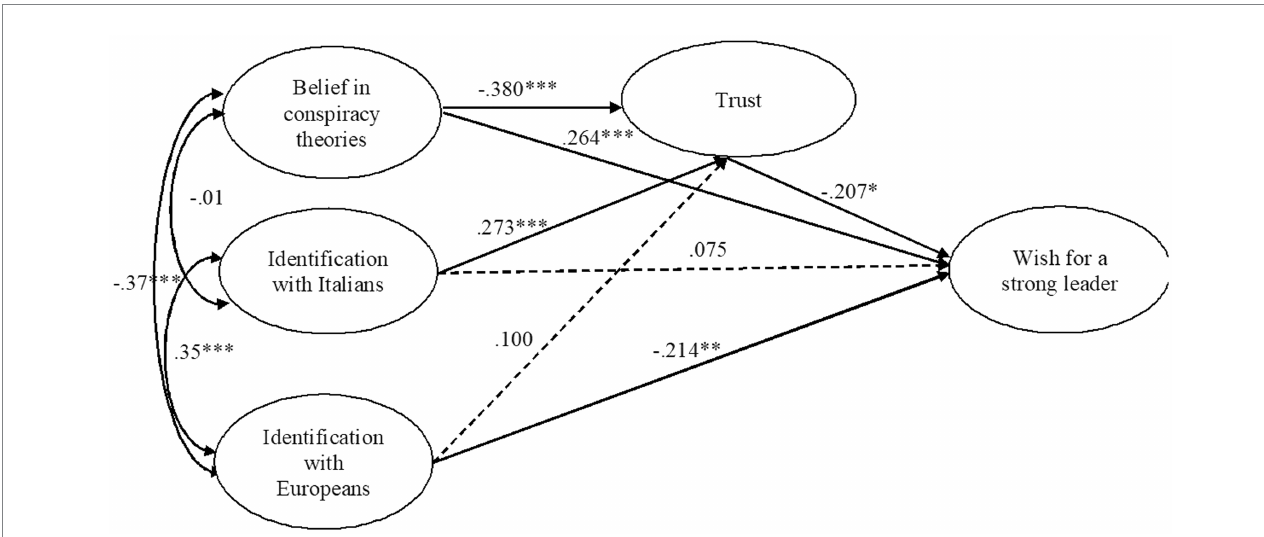
FIGURE 1 Standardized solution of the model testing the relations among identification with Italians and Europeans, belief in conspiracy theories, trust, and the wish for a strong